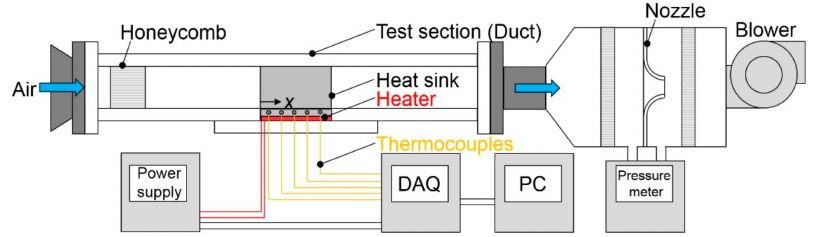
Figure 3. Schematic diagram of the experimental